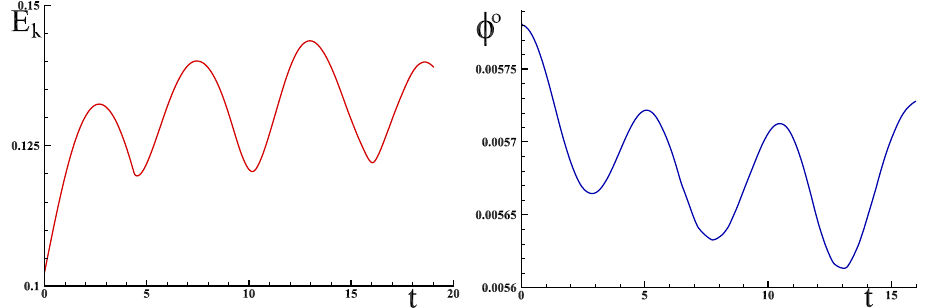
Figure 4. Evolutions of the mean kinetic energy E k and the scalar potential φ o where E k and φ o are given in m 2 s − 2 and t in s